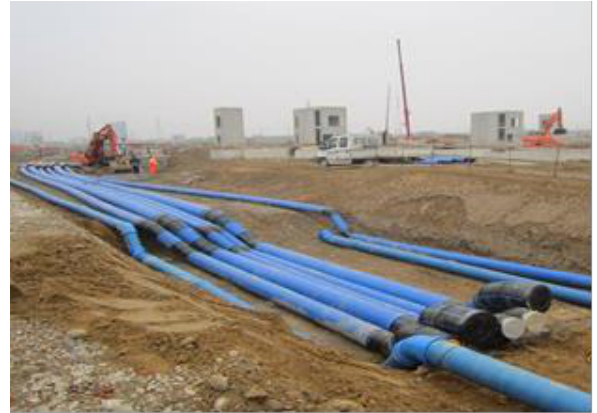
Figure 9 . BIM and GIS integrated